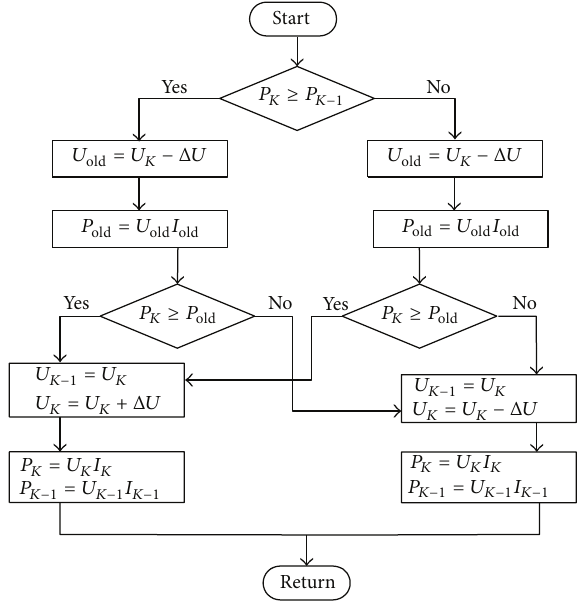
Figure 1: Flowchart of improved perturbation and observation